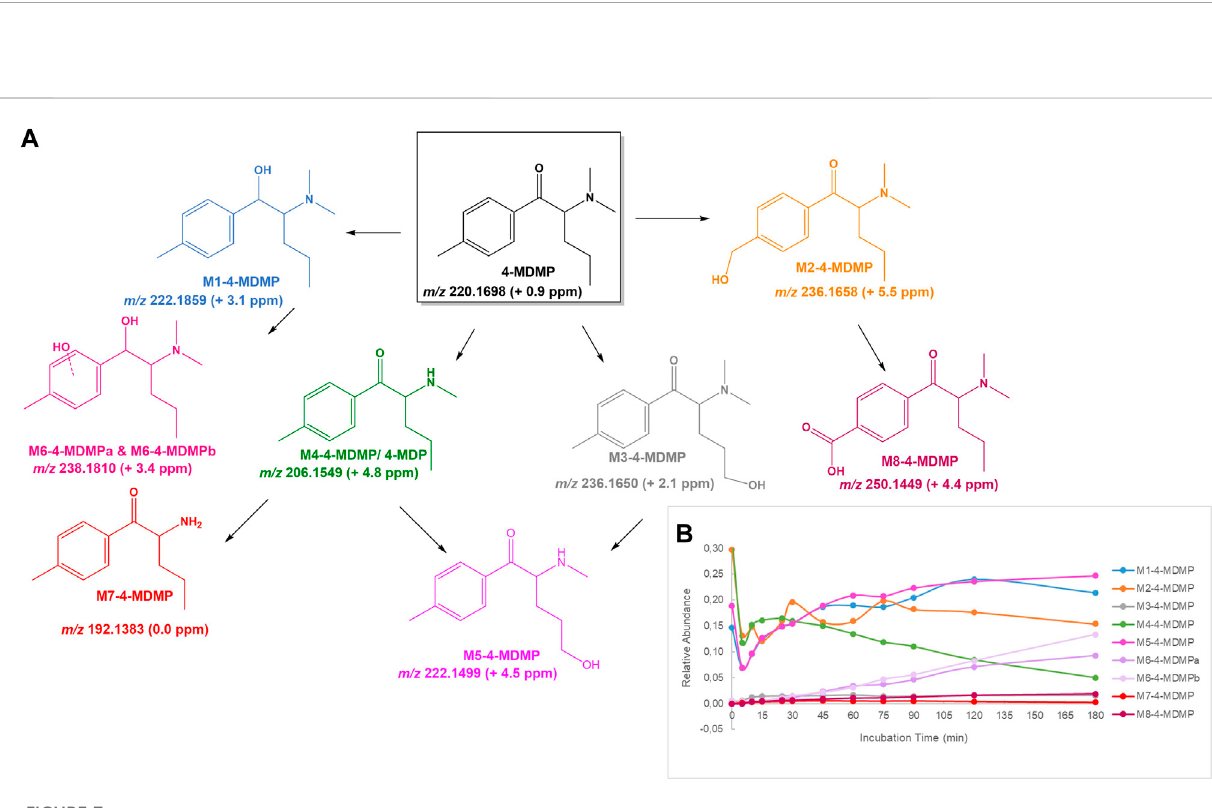
concomitant loss of an oxygen and methyl radical. M4-4-MDMB and M5-4-MDMB present a 16 u mass increment when compared with the reduction metabolite M1-4-MDMB and the parent 4-MDMB , respectively, which suggests their